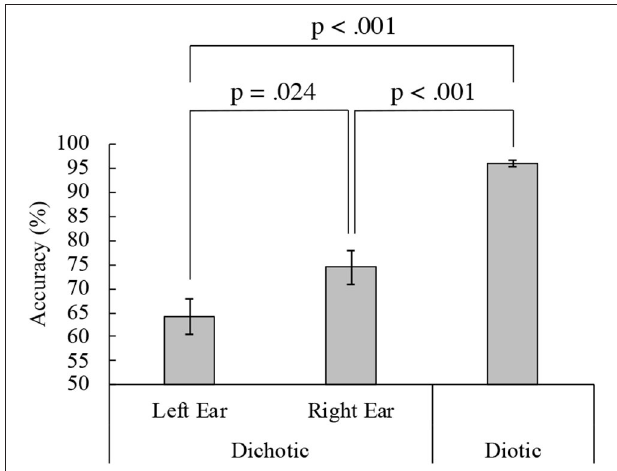
FIGURE 2 | Dichotic and diotic task accuracy. Mean accuracies from 18 participants in the left (64.15%) and right (73.61%) ears in the dichotic and diotic (96.44%) listening tasks. Error bars indicate standard error of the